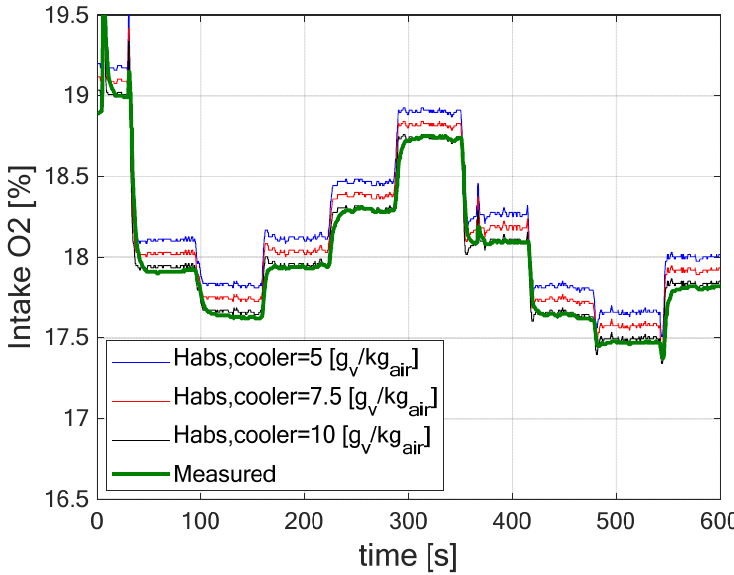
Figure 8. Values of the intake O 2 concentration predicted by the newly developed procedure (corrected with Equation (25), assuming different values of H abs,cooler , in order to consider the presence of residual humidity in the gases exiting the analyzer cooler) and the values measured by the O 2 analyzer for the transient test reported in Figure 3b.